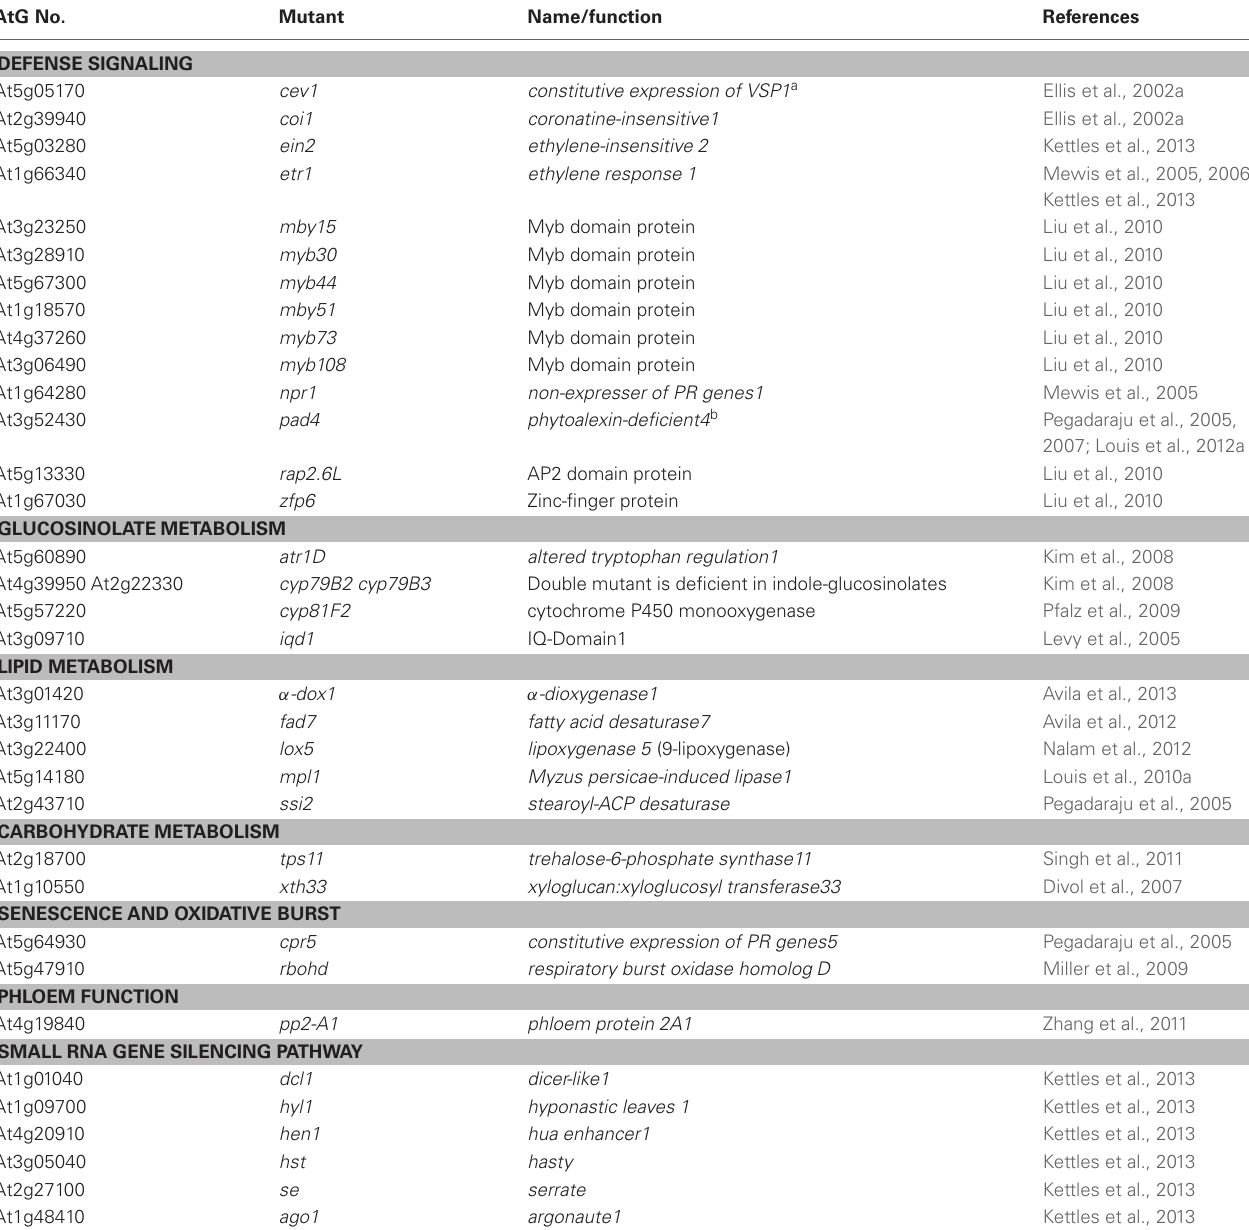
Table 1 | Arabidopsis mutants that impact green peach aphid colonization. AtG